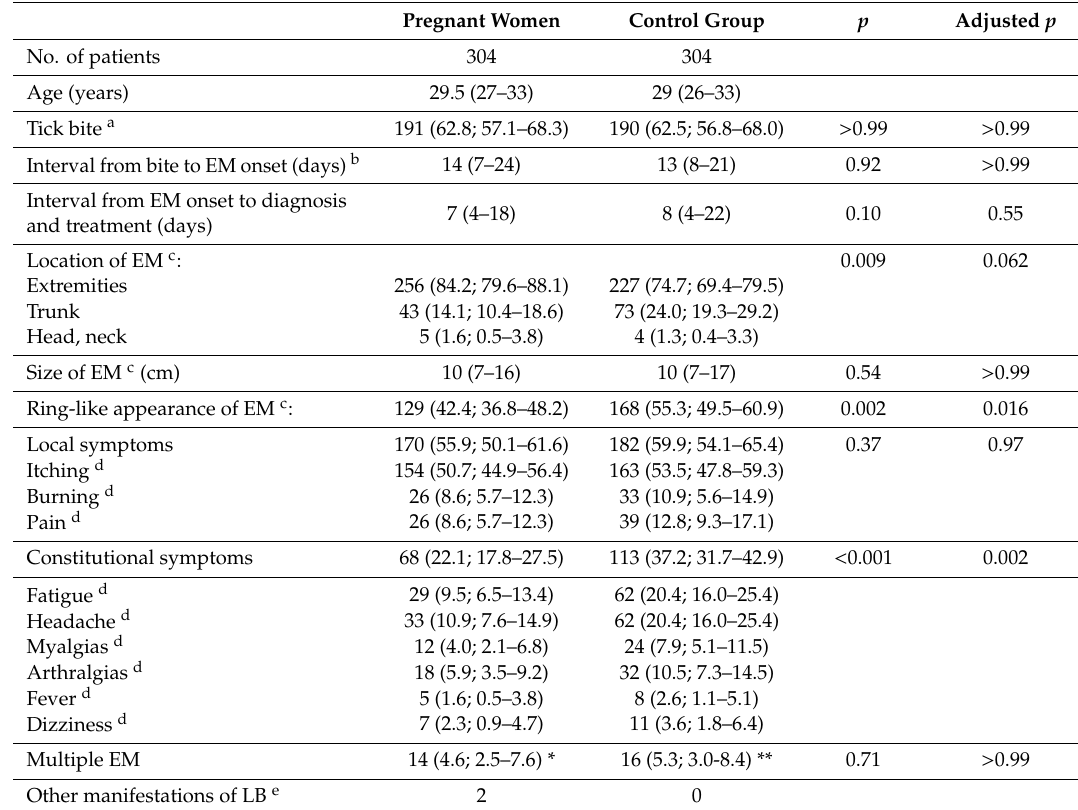
Table 1. Basic demographic, clinical, and laboratory characteristics of 304 pregnant women before antibiotic treatment of erythema migrans in comparison with 304 sex- and age-matched patients diagnosed with erythema migrans in the same